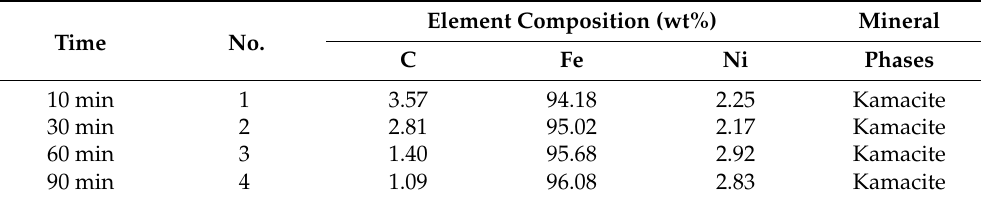
Table 6. EDS analysis results of reduction product for areas in Figure